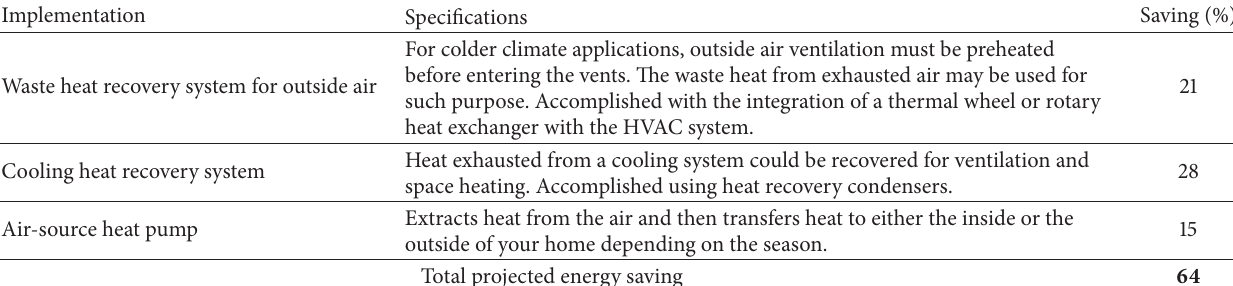
Table 1: Energy-efficient HVAC system and projected energy